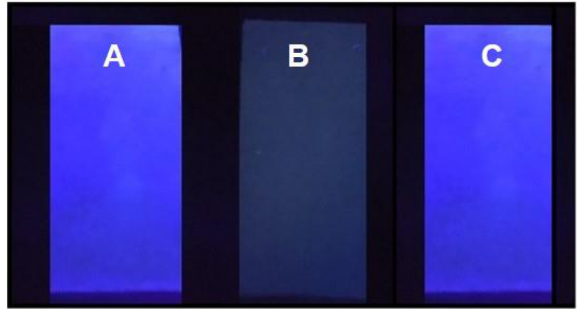
Figure 9. Luminescence picture of the UiO-66-N-Py test paper: ( A ) UiO-66-N-Py, ( B ) UiO-66-N-Py + Fe 3+ (10 −2 M), ( C ) UiO-66-N-Py + Fe 3+ + PPi under UV-light irradiation of 365 nm.